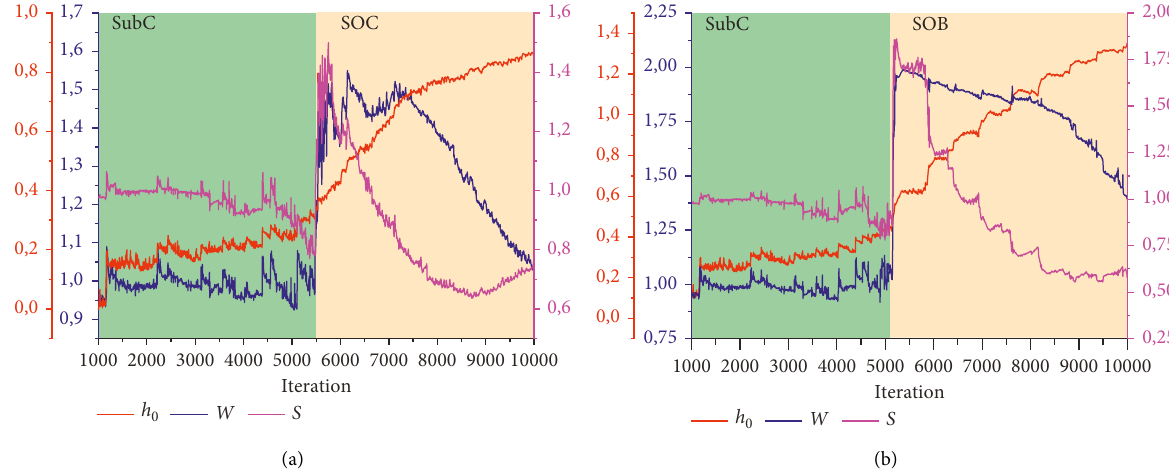
Figure 2: Time series of the maximum position ( h ), width ( W ), and asymmetry ( S ) of the multifractal spectrum for the sandpile cellular 0 automata. (a) Standard rules of the Manna model and (b) lightweight rules of the Manna